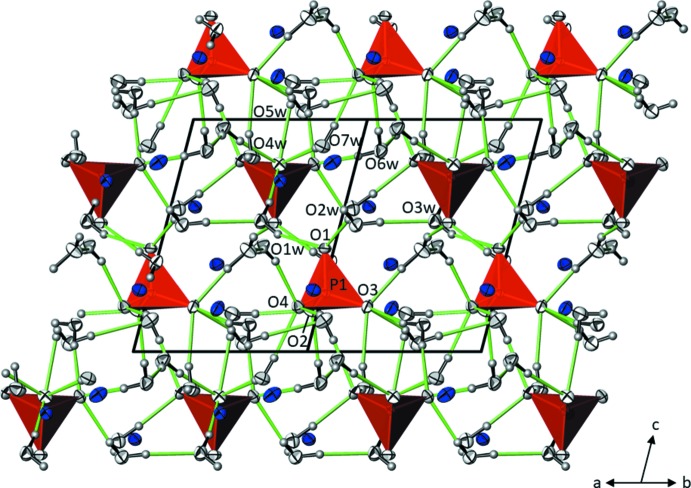
O—D⋯O hydrogen-bonding network (green lines) in the crystal structure of K3PO4·7D2O, viewed along [101]. Displacement ellipsoids are displayed at the 90% probability level.